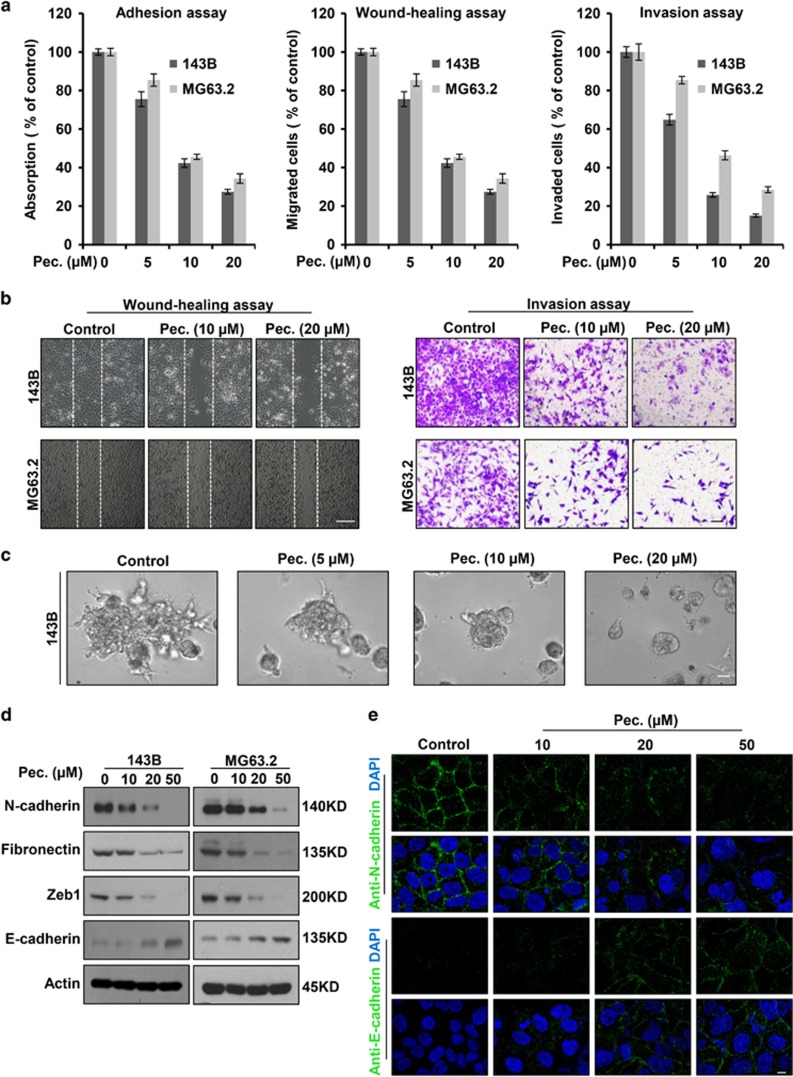
Pectolinarigenin inhibits adhesion, migration, invasion and reversed EMT phenotype in osteosarcoma cells. (a) Left panel, adhesion assay. 143B and MG63.2 cells were pretreated with various concentrations of pectolinarigenin for 12 h. Cells were trypsinized, and seeded on a fibronectin coated 96-well plate. After 15 min, non-adherent cells were removed and adherent cells were stained with 0.1% crystal violet. The precipitates were dissolved in 30% acetic acid, and the absorption at 590 nm was acquired. Middle panel, wound-healing migration assay. 143B and MG63.2 cells were seeded into six-well plates and left to grow to full confluence. Cells were scratched to create a wound and exposed to different concentrations of pectolinarigenin. Images were acquired after 12 h. Cell migration was quantified manually. Right panel, invasion assay. 143B and MG63.2 cells were resuspended in serum-free medium and seeded into the upper chamber of the transwell inserts precoated with Matrigel. Complete medium containing different concentrations of pectolinarigenin were added in the bottom well. After 12- h incubation, images were obtained. Cell invasion was quantified manually. (b) Representative images of migration (left panel) and invasion assay (right panel). Scale bar, 100 μm. (c) 3D culture assay. 143B cells were seeded onto solidified Matrigel. Complete medium containing 10% Matrigel and increasing concentrations of pectolinarigenin were added on top of the cells. Four days later, cells were photographed using an inverted microscope. Scale bar, 100 μm. (d) 143B and MG63.2 cells were incubated with increasing doses of pectolinarigenin for 72 h. EMT-related markers were probed by a western blot assay. (e) 143B cells were treated with pectolinarigenin at the indicated doses. Cells were examined for the expression of N-cadherin (green) and E-cadherin (green) by immunofluorescence staining. Nuclei were stained with DAPI (blue). Scale bar, 10 μm